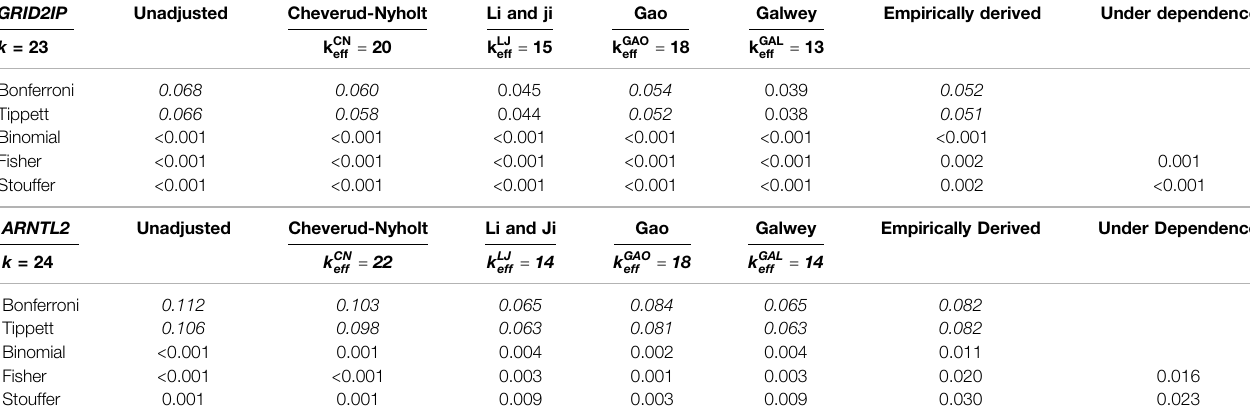
TABLE 1 | Combined p -values for the GRID2IP and ARNTL2 genes based on the methods presented in Section 2 (combined p -values that show non-signi fi cant associations are accentuated in italic ).